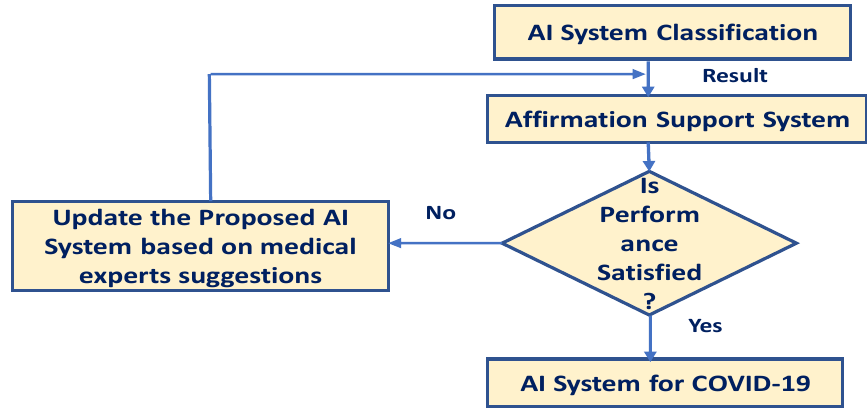
Figure 9. Working principle of Affirmation Support System. Table 3. Performance analysis of deep convolution neural network architectures on CT images.